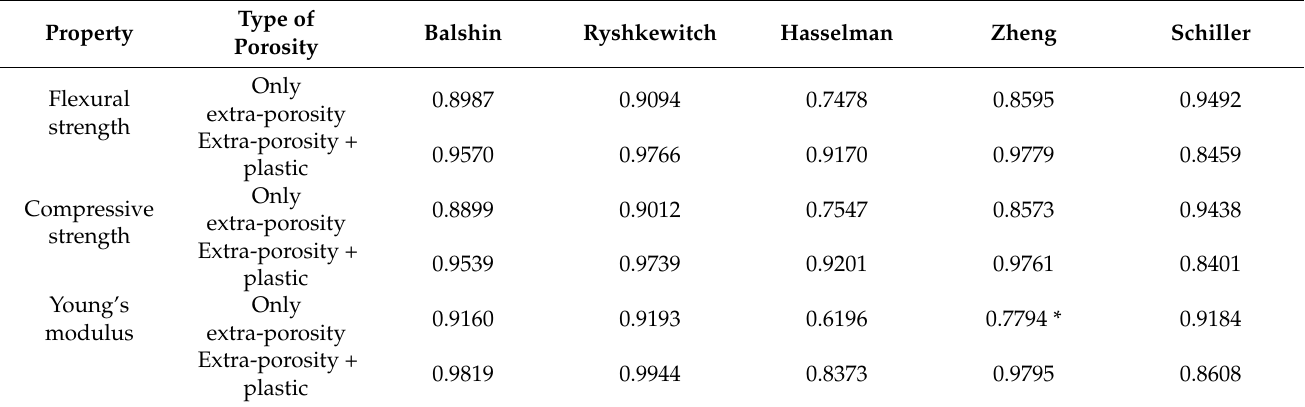
Table 1. R 2 values relative to the fitting curves of Figure 3, related to the Balshin, Ryshkewitch, Hasselman, Zheng, and Schiller